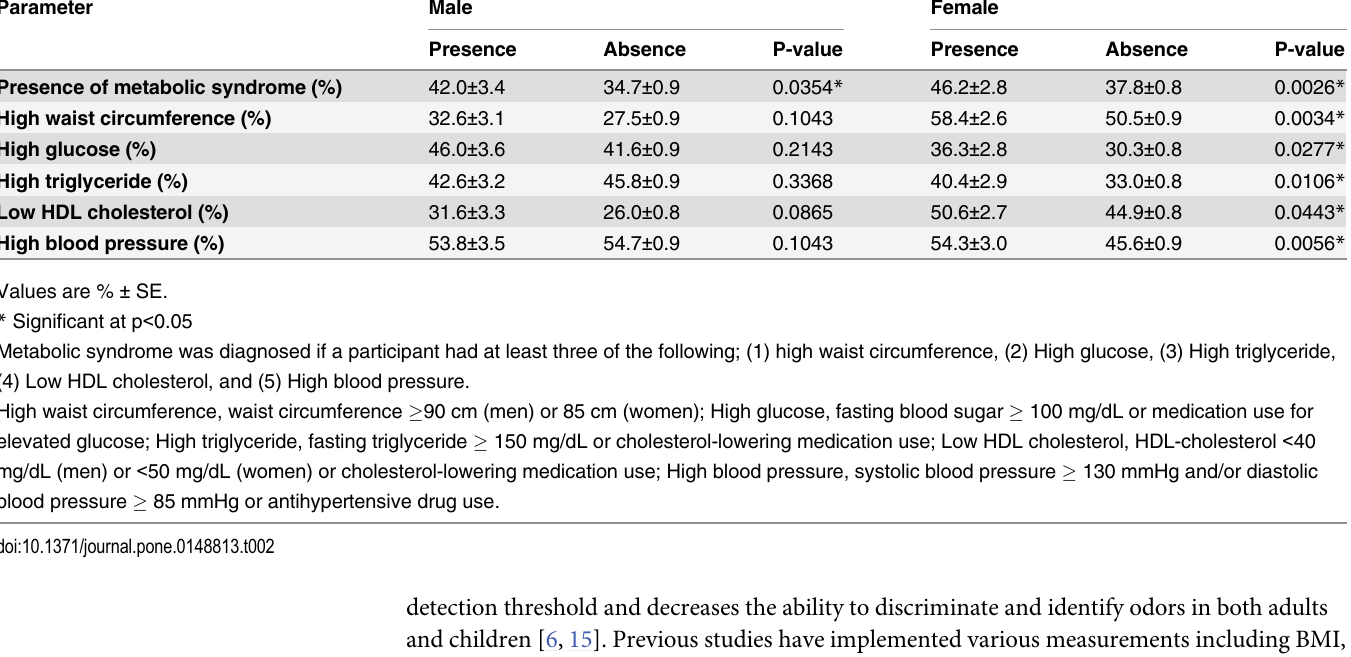
detection threshold and decreases the ability to discriminate and identify odors in both adults and children [6, 15]. Previous studies have implemented various measurements including BMI, hip-to-waist ratio, and WC to investigate the impacts of obesity on the brain and cognitive health. Among these measurements, WC is strongly associated with prolonged P3 latencies of olfactory event-related potentials (i.e., slower cognitive processing), which is an objective mea- sure of the sensory-perceptual processing of odor stimuli [16]. These results may be concor- dant with the present result that people with olfactory dysfunction had larger WC than those without olfactory dysfunction.